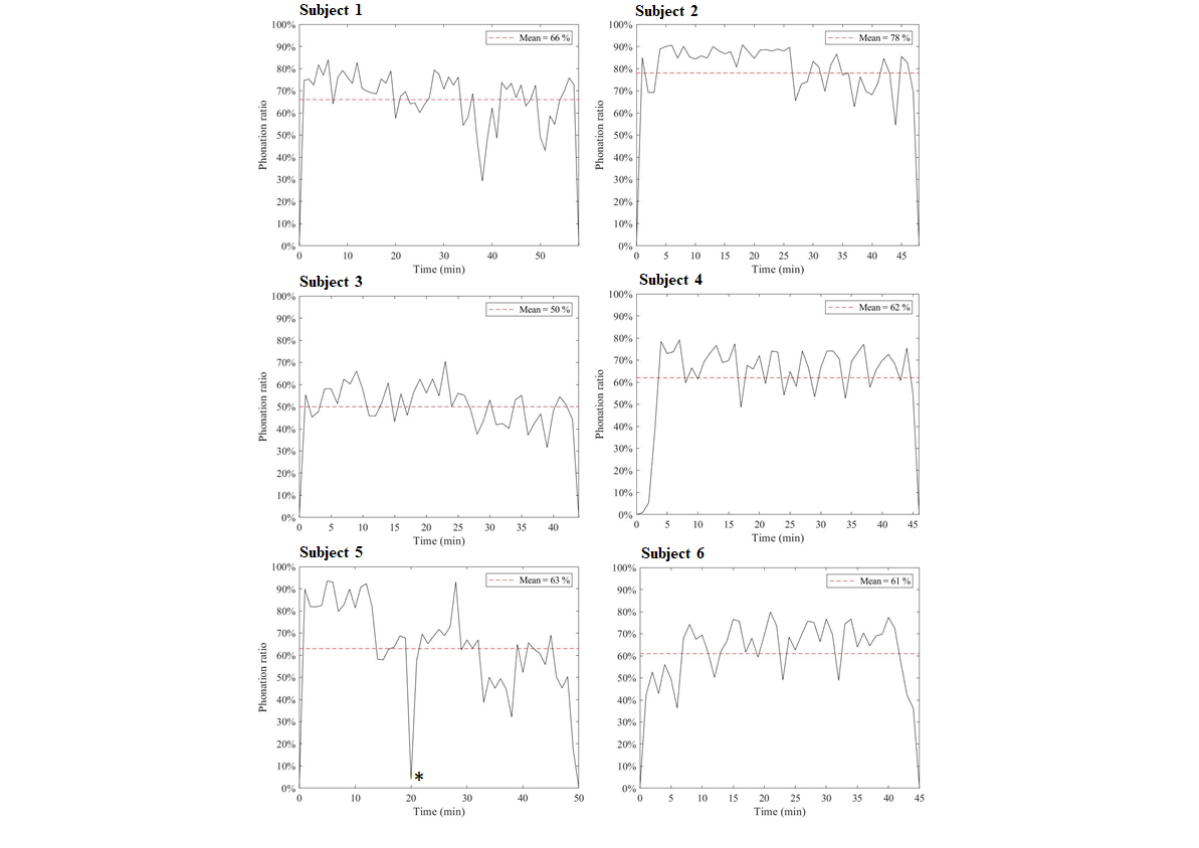
Figure 4. Phonation ratio over time for the 10 teachers (Subjects 1-6).